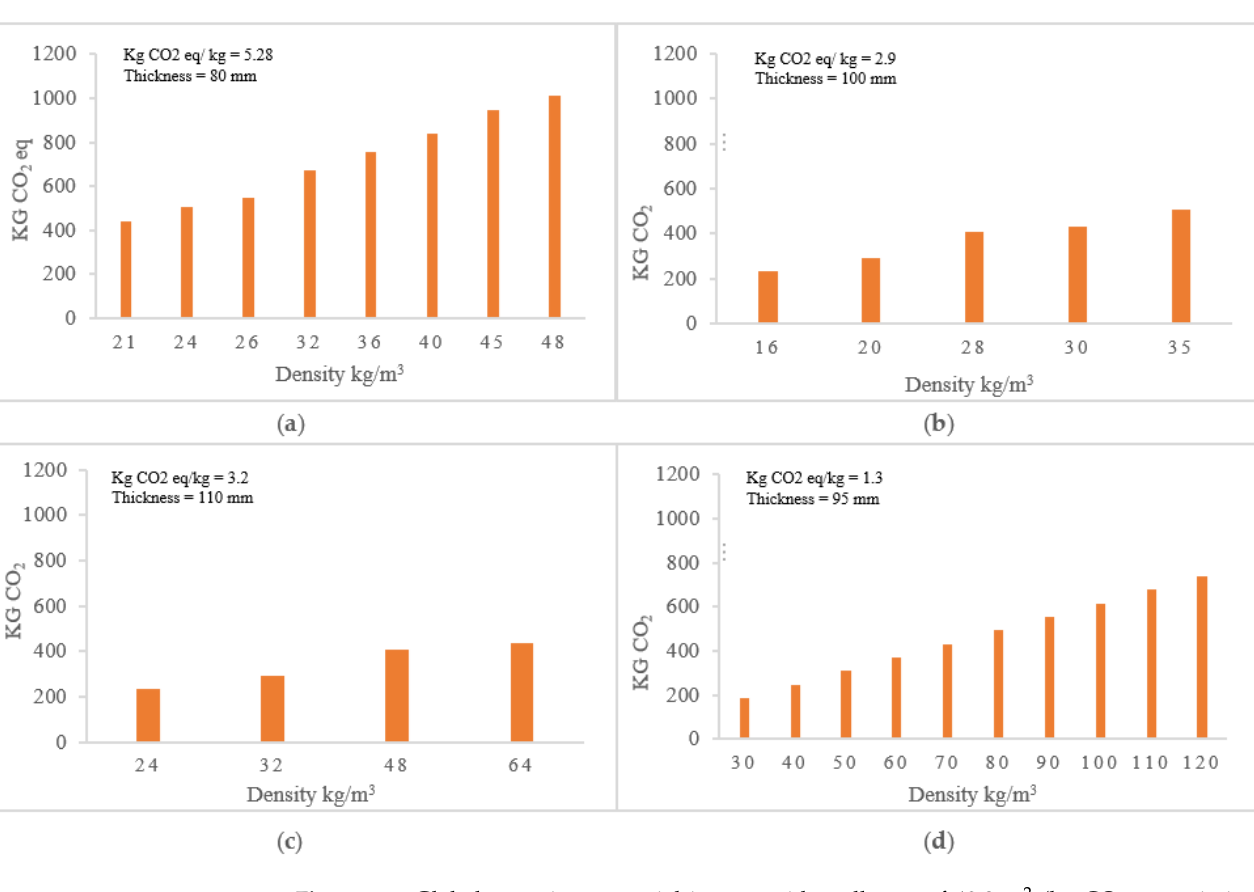
Figure 12. Global warming potential impact with wall area of 49.8 m 2 (kg CO 2 eq emissions), ( a )